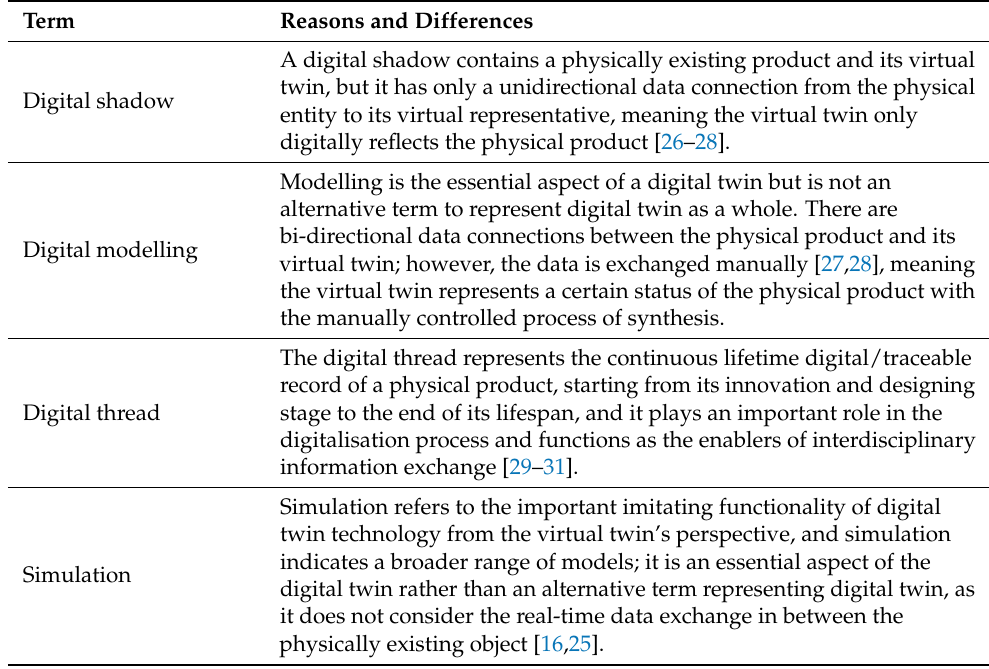
Table 1. Common misconceptions of the digital